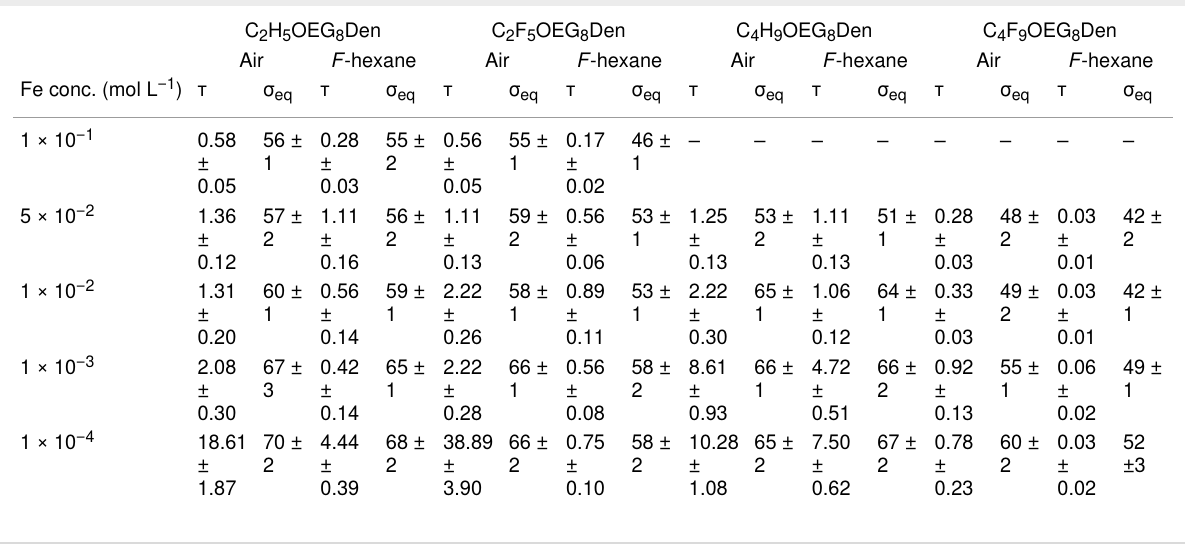
Table 1: Characteristic adsorption time τ (h) and interfacial tension at equilibrium σ eq (mN m − 1 ) of the IONPs grafted with hydrogenated or fluorinated